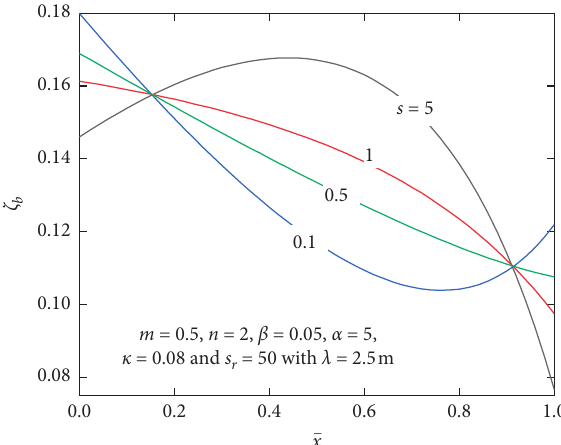
Figure 7: Dependence of the dimensionless buckling load b on the friction β , for different friction ratios s .